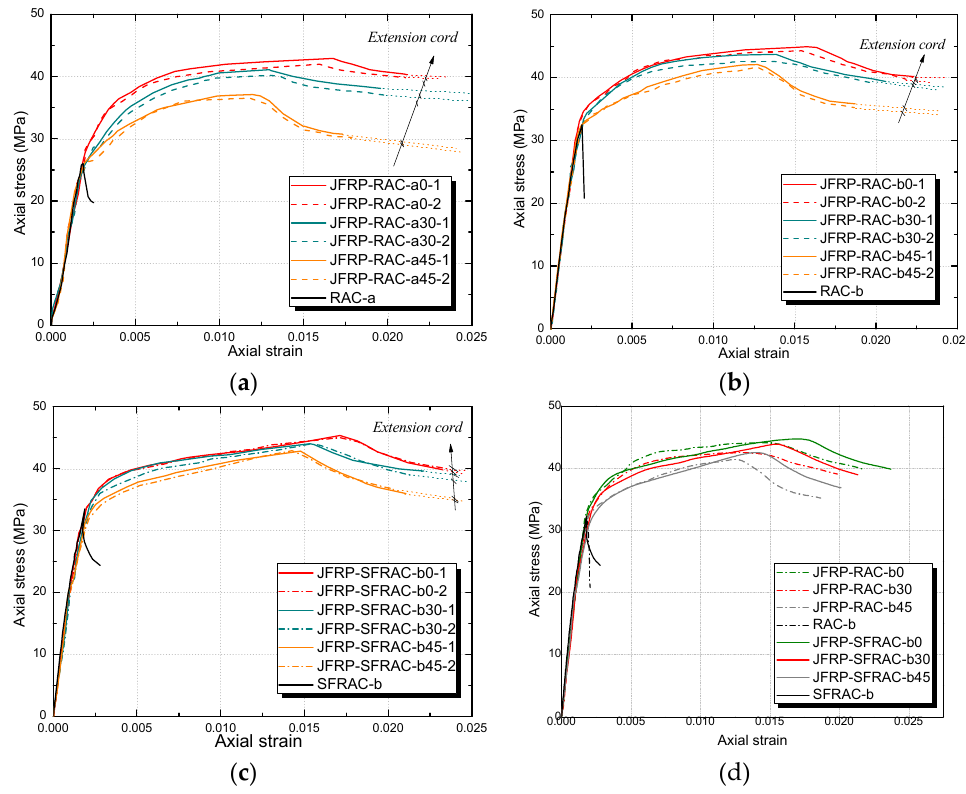
Figure 7. The axial stress–strain relationships of JFRP–RAC and JFRP–SFRAC: ( a ) JFRP–RAC with different orientations of jute fibers ( f co = 25.0 MPa); ( b ) JFRP–RAC with different orientations of jute fibers ( f co = 32.5 MPa); ( c ) JFRP–SFRAC with different orientations of jute fibers ( f co = 33.5 MPa); ( d ) axial stress–strain of JFRP–RAC vs. JFRP–SFRAC.